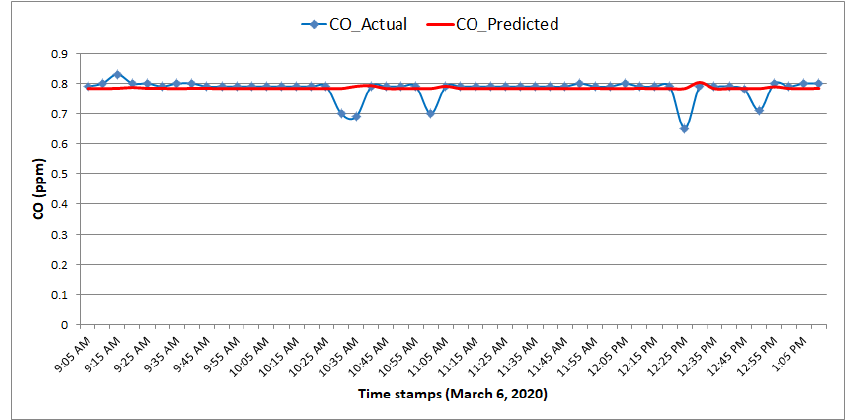
Figure 16. Predicted values of CO after every 5 min vs. Actual values.